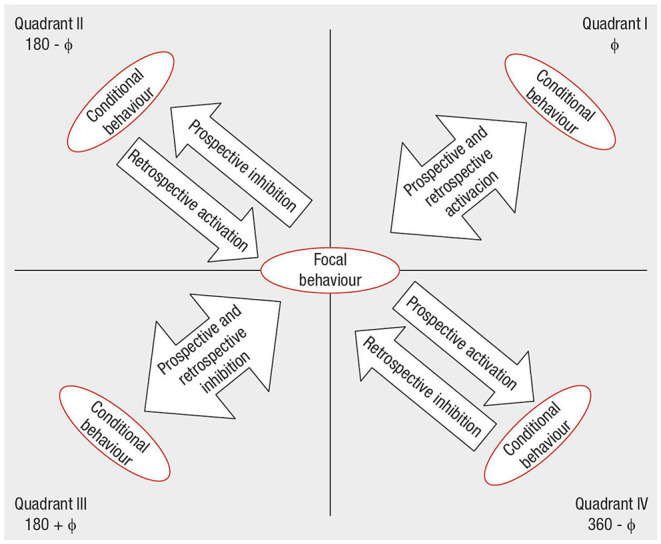
Polar coordinates' vector map that depicts the relationship between the focal and conditional behaviors, based on the quadrant where the vector is located (retrieved from Aragón et al., 2016, p. 5). The authors granted permission to use the image.